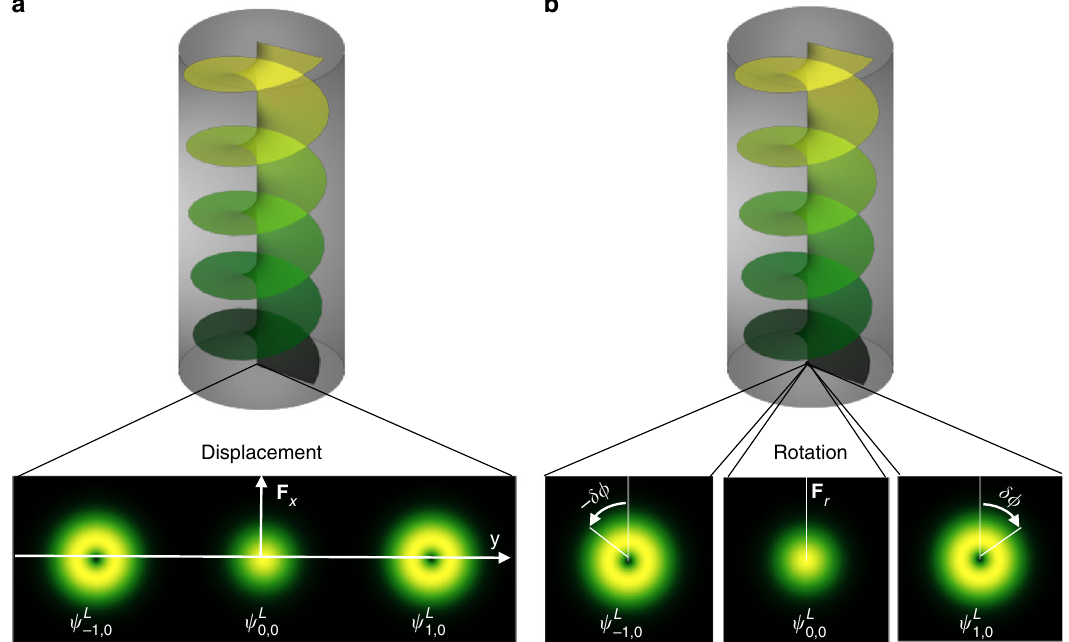
Fig. 3 Demonstration of the orbital angular momentum (OAM)-dependent magnon Hall effect. a Transverse displacement by a driving force F x along the x -direction and b uniform rotation by a r 2